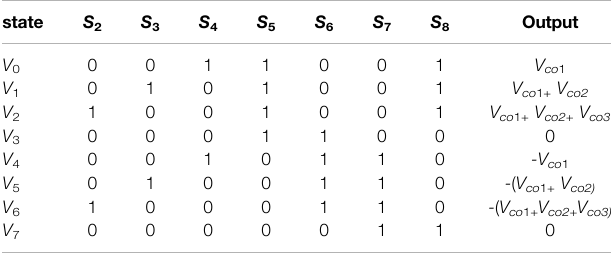
TABLE 1 | Switching states of the seven-level multilevel